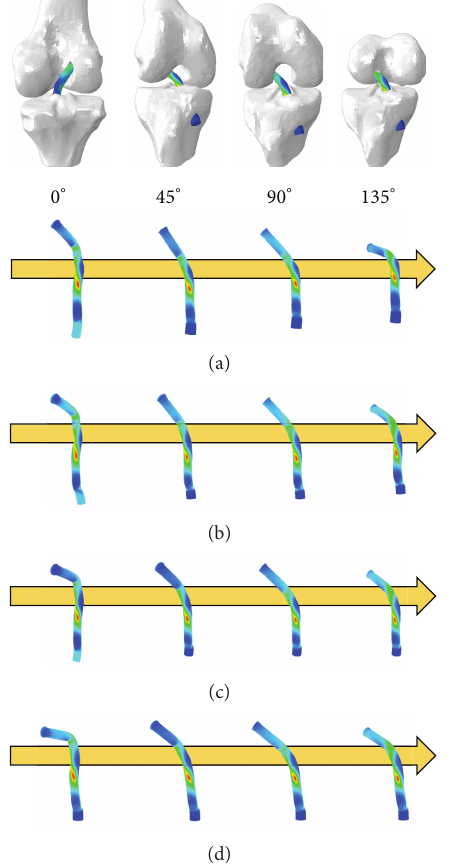
Figure 10: von Mises stress of the simulation results for the models using (a) Method 1, (b) Method 2, (c) Method 3, and (d) Method 4.